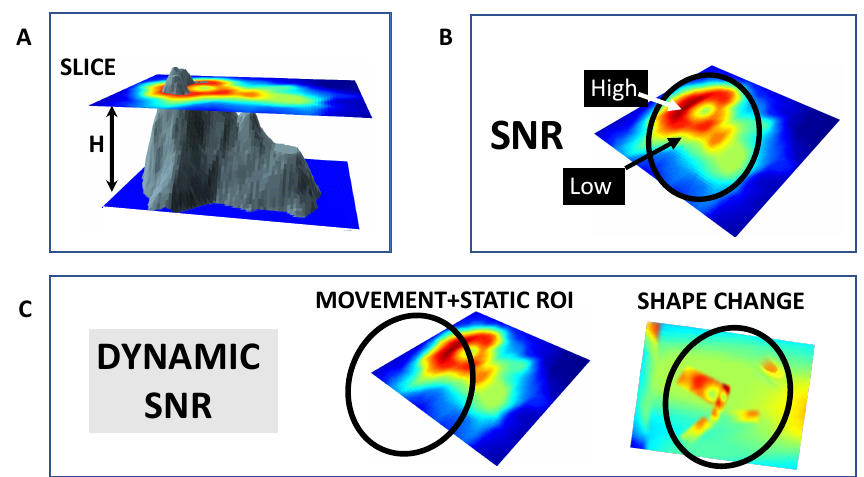
Figure 3. The dynamic nature of the signal-to-noise ratio in live imaging. ( A ) In confocal microscopy, the focal plane is defined by the top of the position of the confocal slice through the object (grey). This slice has a small thickness H, which determines how much out-of-focus light is detected. ( B ) The signal-to-noise ratio is higher where the signal is stronger: if the sensor is evenly distributed, the signal-to-noise ratio at a given point reflects the depth/shape of the object at that point. ( C ) In living samples, the signal-to-noise ratio is constantly changing: it decreases if the signal is lowered because the object moves out of a statically-defined region of interest (oval) or if the shape of the object changes in certain ways, e.g., becoming less compact and thus increasing weak edge effects. The idealised cellular object was created from the R volcano dataset [59], using the plot3D R package